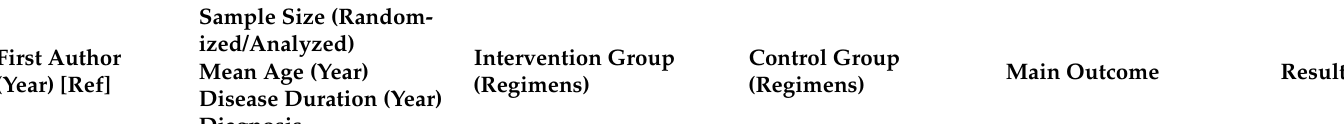
Table 1. Summary of randomized controlled trials of herbal medicine for Behçet’s